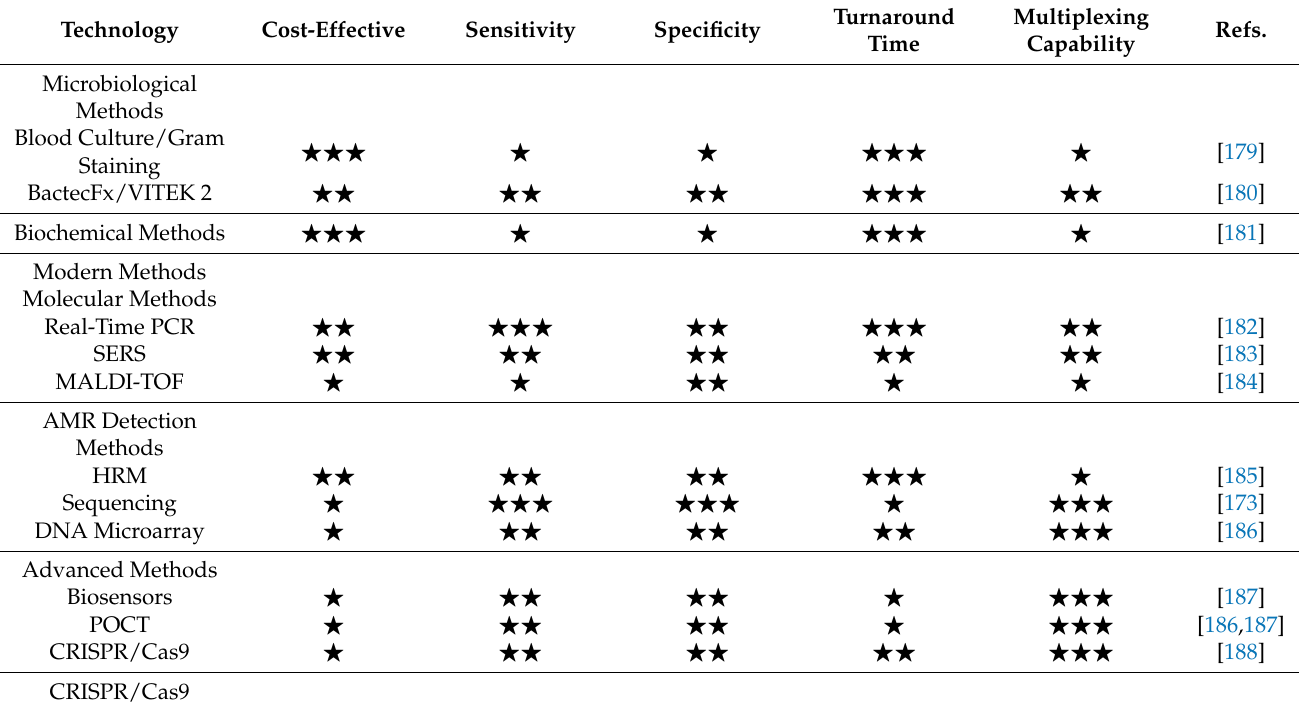
Table 3. Different infectious polymicrobial diseases: a comparison of molecular diagnostic